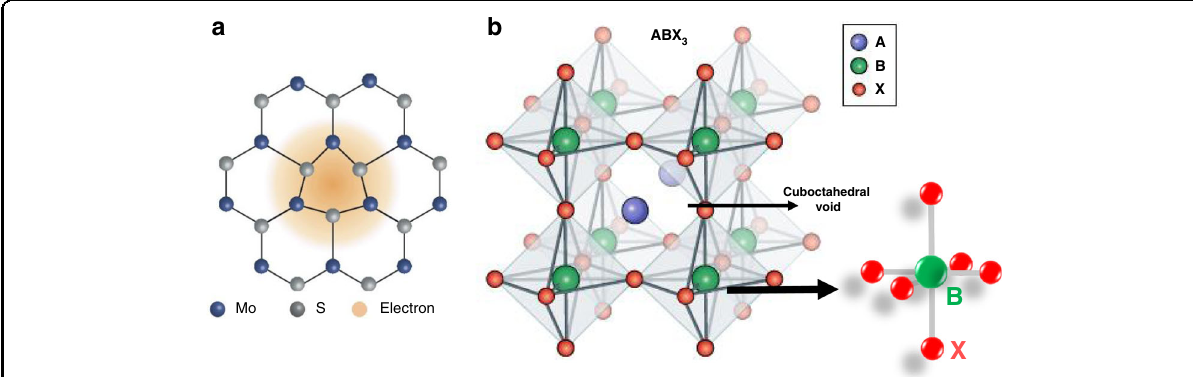
Fig. 8 The schematic illustration of crystal structure in MoS 2 and lead halide perovskite. ( a ) polaron formation in MoS 2 and ( b ) the crystalline structure of lead halide perovskite (MAPbX 3 ) that favors large polaron formation. The fi gures are taken with permission from ( a ) 38 and ( b ) 39 and modi fi ed. The fi gures are taken with permission from ( a ) ref. 147 and ( b ) ref. 148 and modi fi